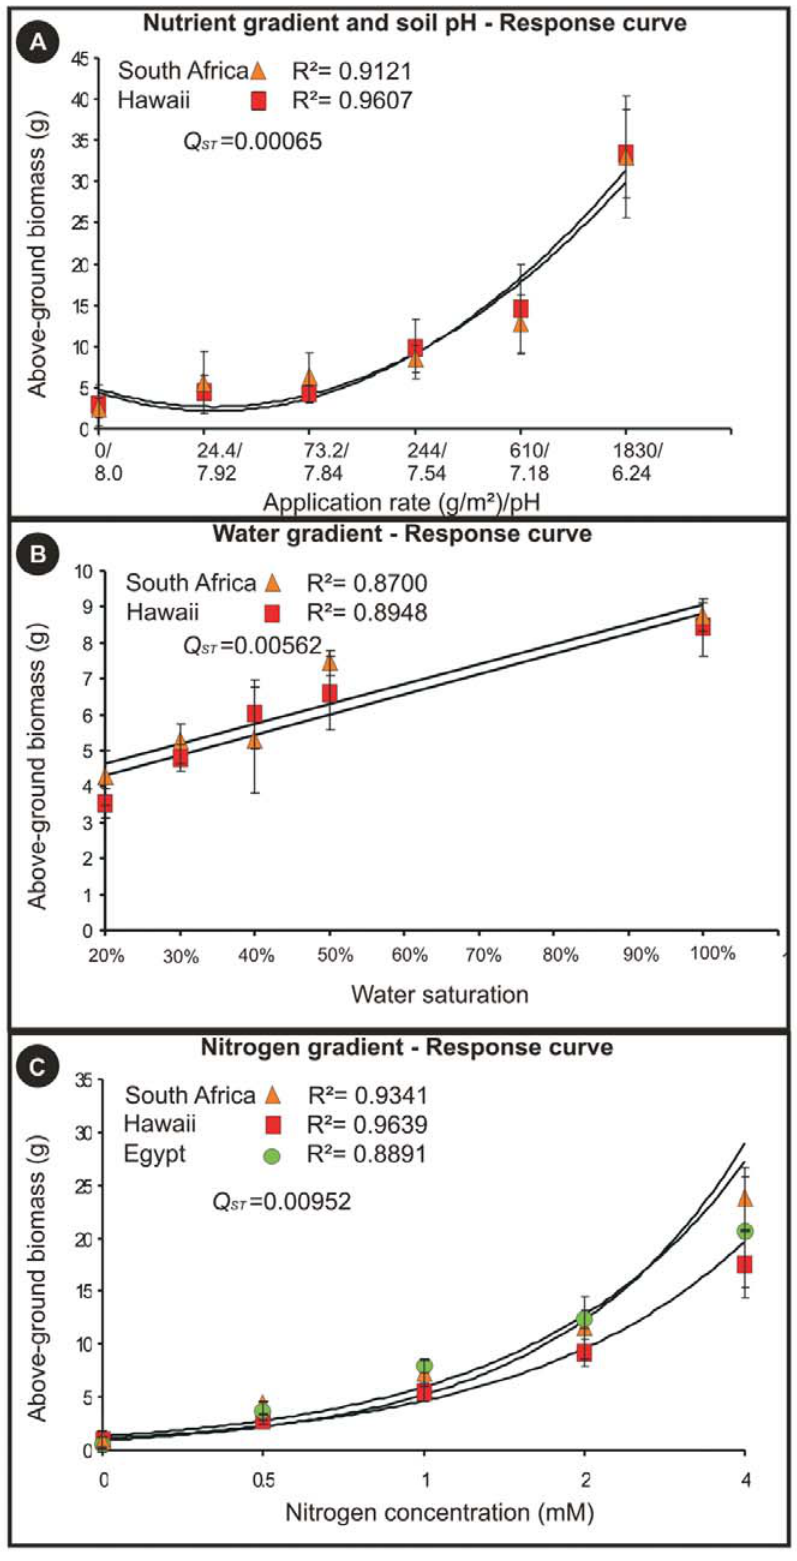
Figure 3. Genotypic reaction norms for (A) nutrient and soil pH gradient, (B) water gradient and (C) nitrogen gradient showing mean ( 6 s.e.m.) biomass accumulated in response to each treatment level. Egyptian populations were only included for the nitrogen treatments. The corresponding Q ST values for fitness correlates are indicated on each graph.